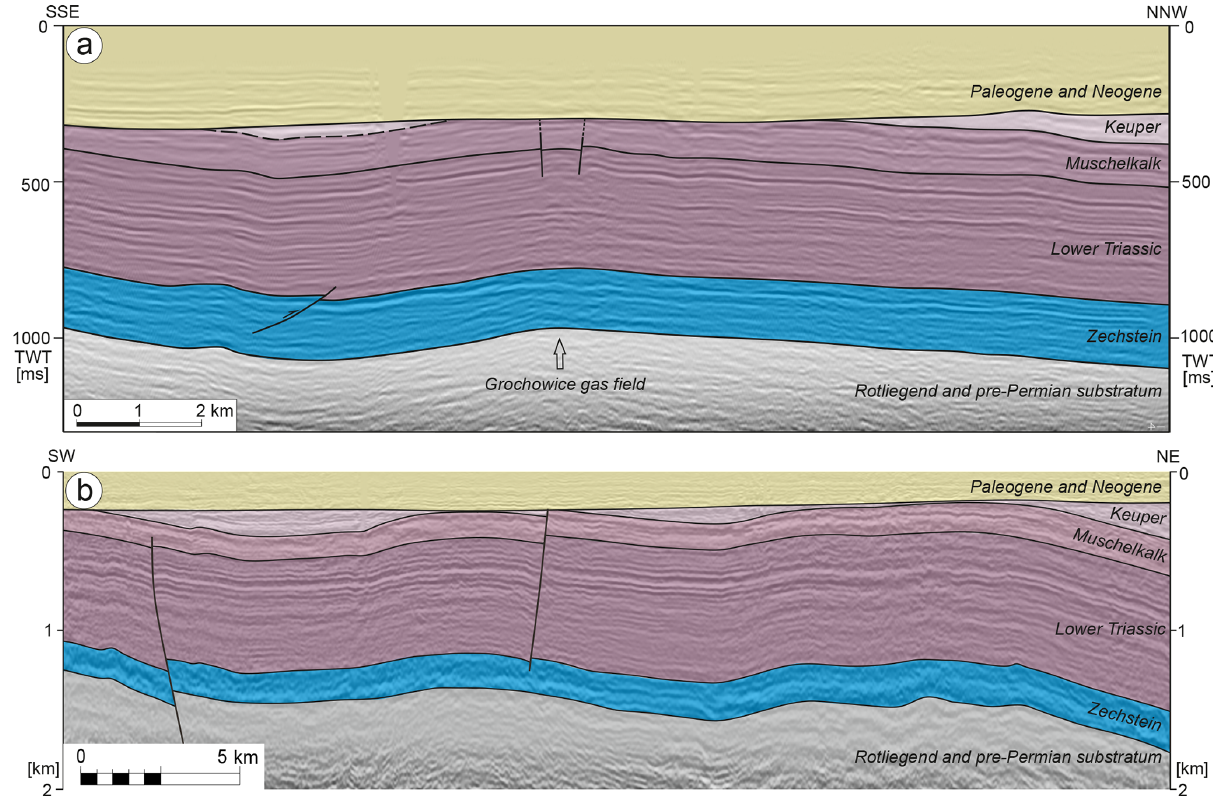
Figure 4. Two seismic profiles from the Fore-Sudetic Homocline (location in Fig. 2) showing very gentle folds in Triassic and Permian (Rotliegend not marked). Note steep to low-angle mainly reverse faults. The anticlines are structural traps for hydrocarbons, with gas fields known in Rotliegend strata (Grochowice gas field in Fig. 4a). Please note the different scales of the two profiles.